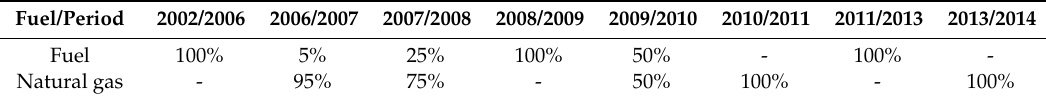
Table 6. Type of fuel used between 2002 and 2015. Source: Field work.